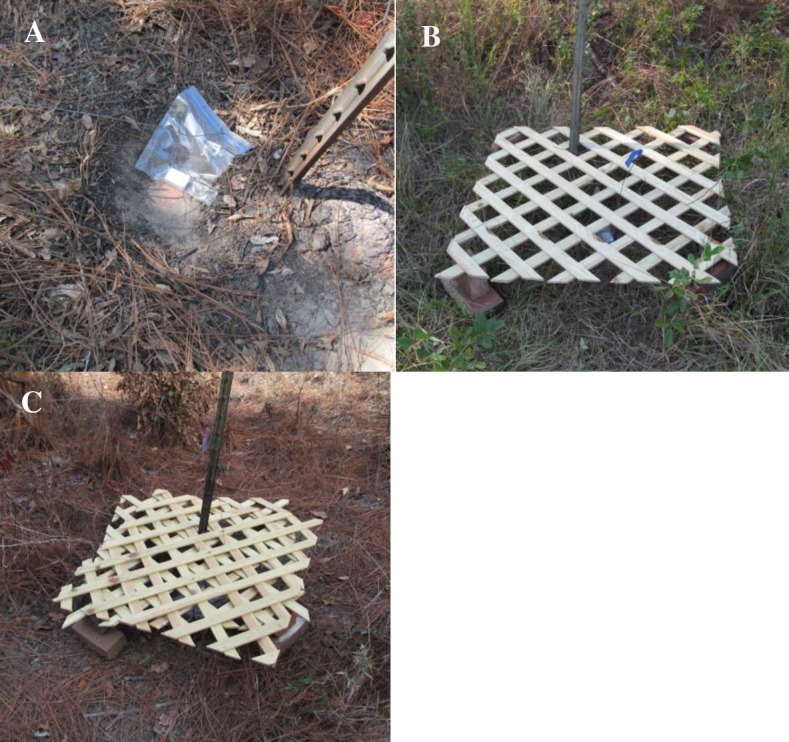
Set-up of trials to determine effect of cover on accuracy of i-gotU GT-120 GPS loggers.Cover treatments included A) no cover, B) logger centered under a single layer of wooden lattice, and C) logger centered under two layers of lattice, offset. The GPS loggers were set at ground control points (GCPs) with accuracy known to ≤ 30 cm in Baker County, Georgia, USA in October 2015.